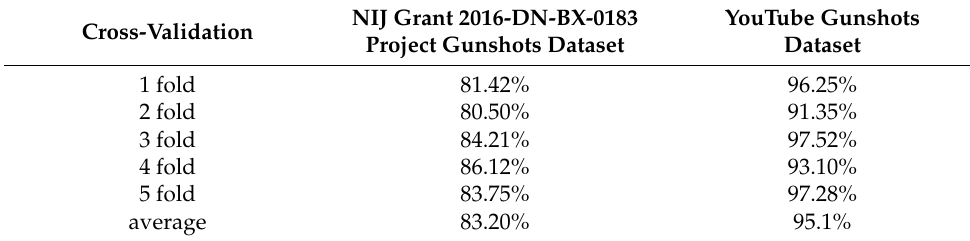
Table 2. 5-fold cross-validation results.